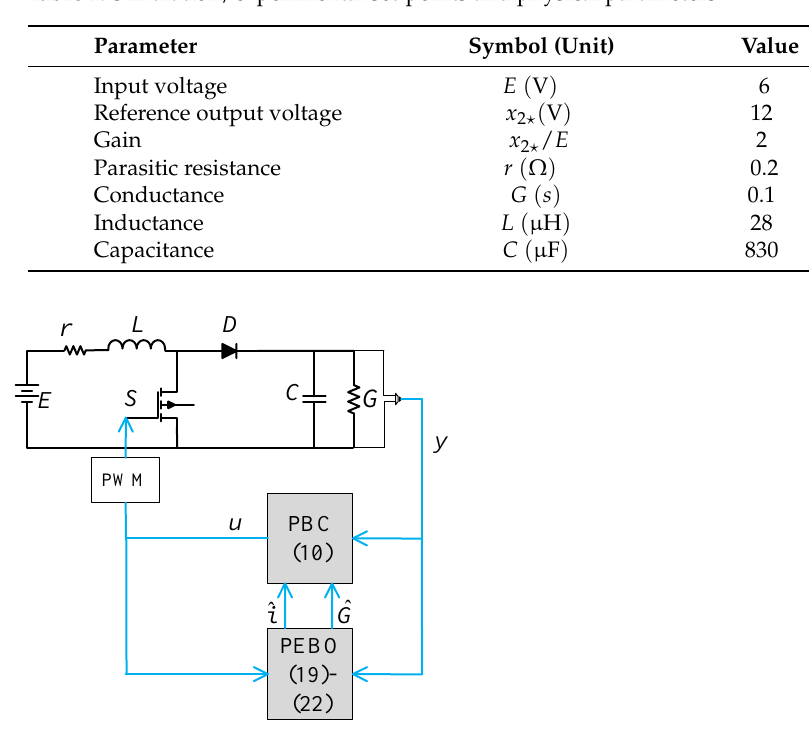
Table 1. Simulation/experimental set-points and physical parameters.